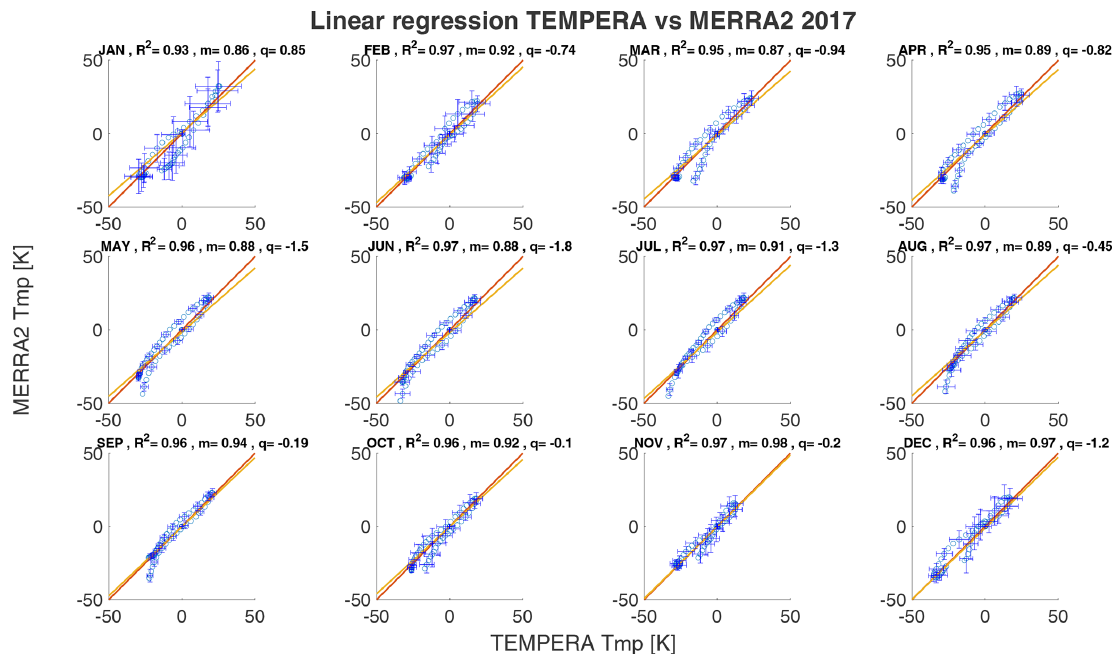
Figure A5. Linear regression of TEMPERA against MERRA2 temperatures for the year 2017.